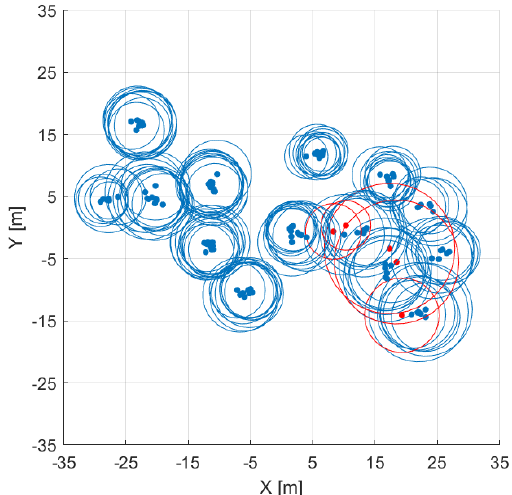
Figure 7. Remaining cylinders ( x - and y -position) are subdivided with DBSCAN into clusters which are marked with different colours